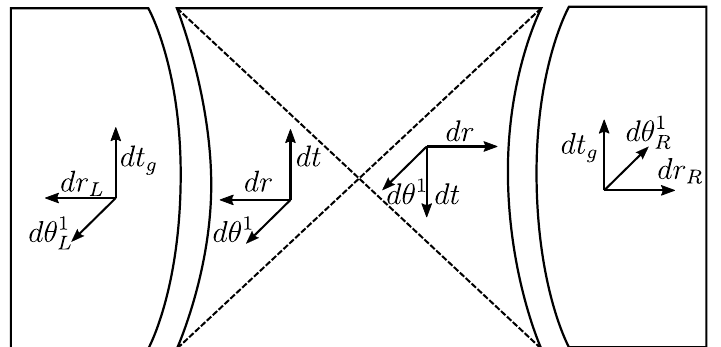
Figure 5 . Spacetime diagram of gluing the wormhole to the throat regions. In the middle we have the Penrose diagram of the eternal black brane, and the sides represent the throat regions. We show the orientation of the coordinate differentials dr , dt , and dθ 1 . The dθ 1 differential points out from the plane of the figure in the left throat and in the wormhole, but it points inwards in the right throat. The three differentials must always form the same right handed